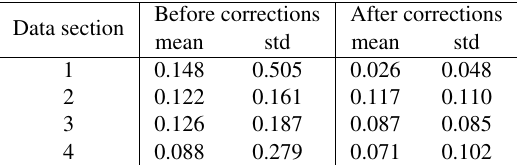
Table 3: Positioning results by using different base station data